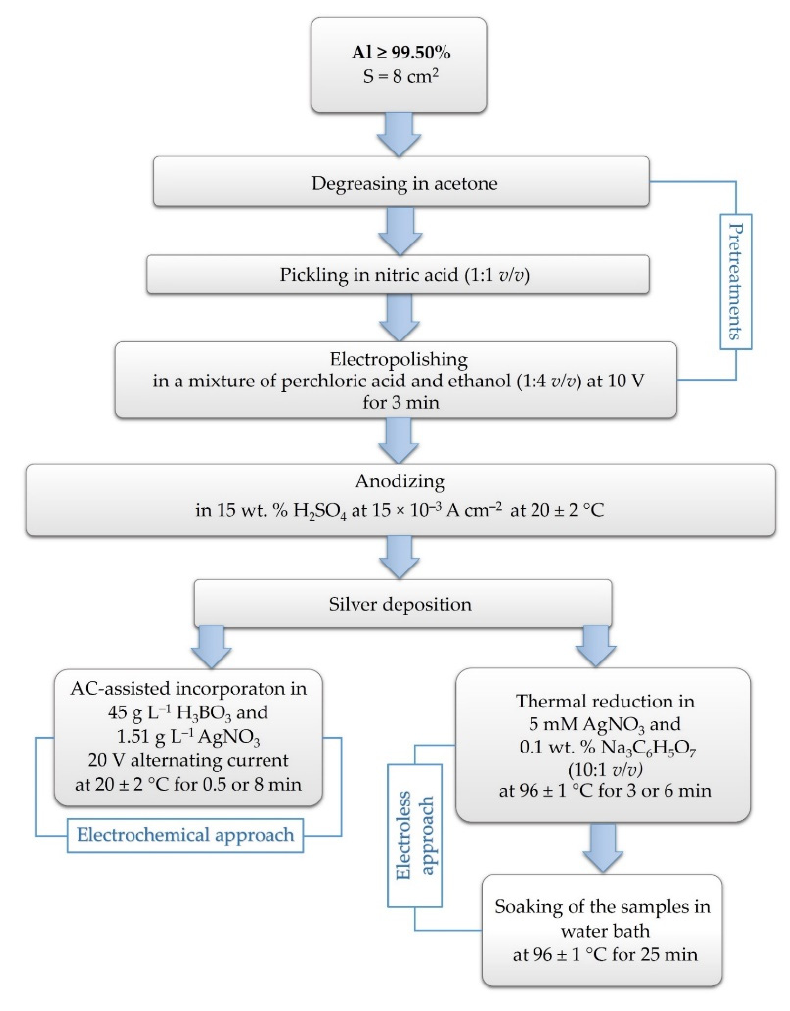
Figure 1. Preparation procedures of silver-modified anodic alumina samples.